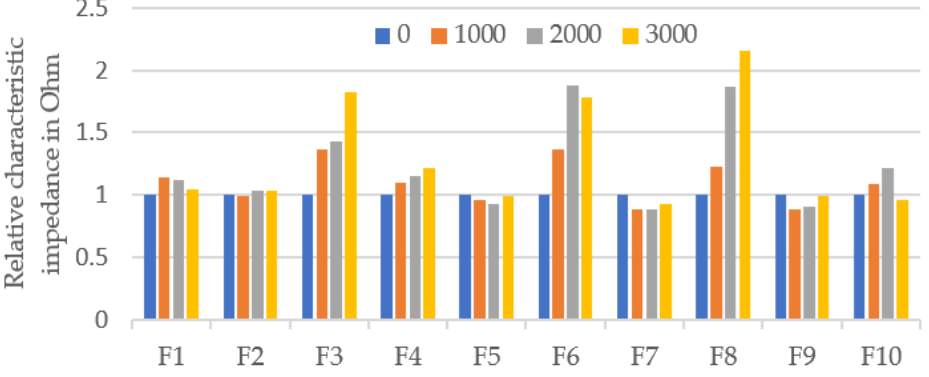
Figure 13. The average characteristic impedance of all TSLs with a PONGE substrate versus rubbing cycles.